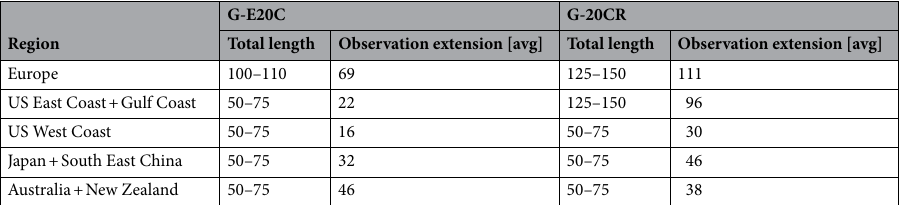
Table 1. Number of years provided/extended by each reconstruction after change point